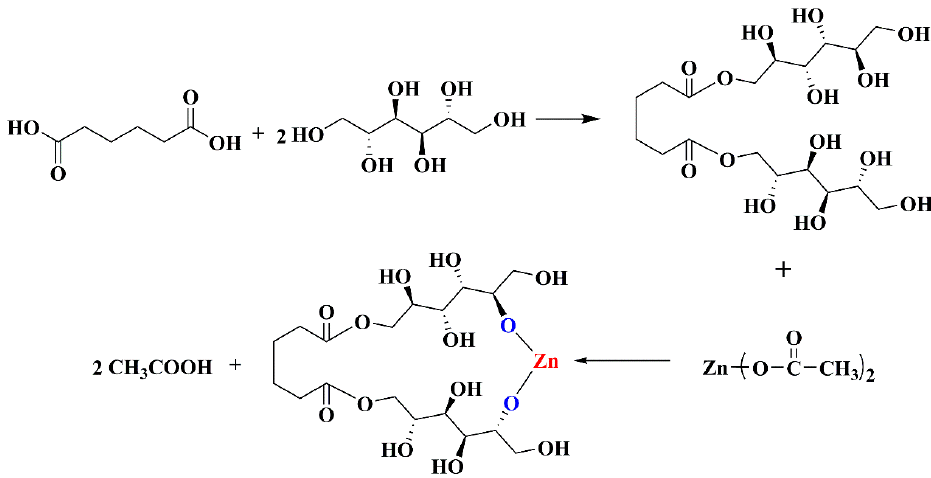
Figure 1. FT-IR spectra of the raw material and product: ( a ) di-mannitol adipate ester (DMAE); ( b ) di- mannitol adipate ester-based zinc metal alkoxide (DMAE-Zn).